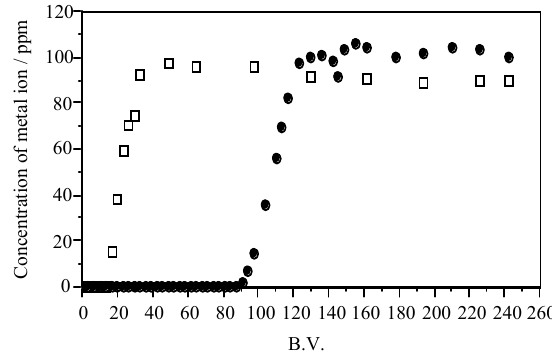
Figure 15. Adsorption of Pb(II) and Zn(II) by SOJR and by WK11 resin [14]. (Copyright 2003 by The Minerals, Metals & Materials Society. Reprinted with permission). ● Pb(II)—SOJR, ▪ Zn( II)—SOJR, ○